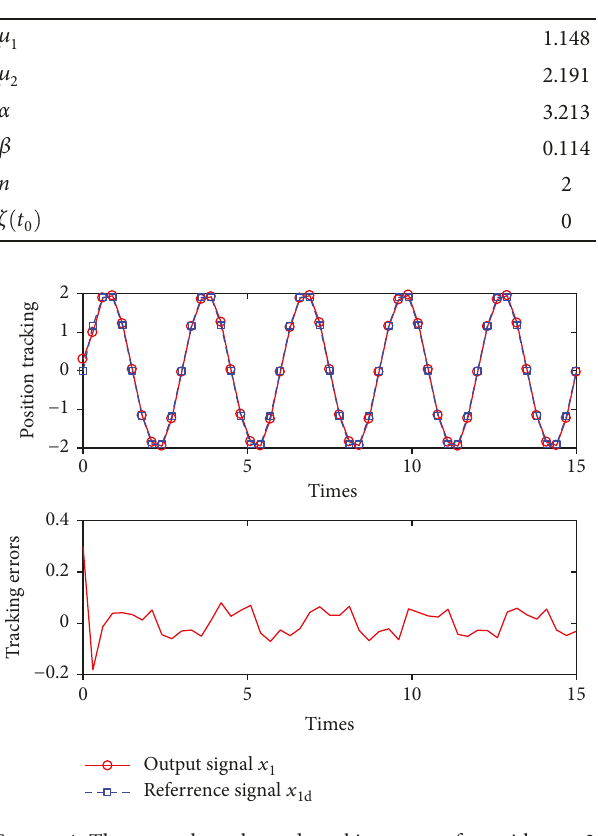
Table 3: The parameters of the Bouc-Wen hysteresis model.